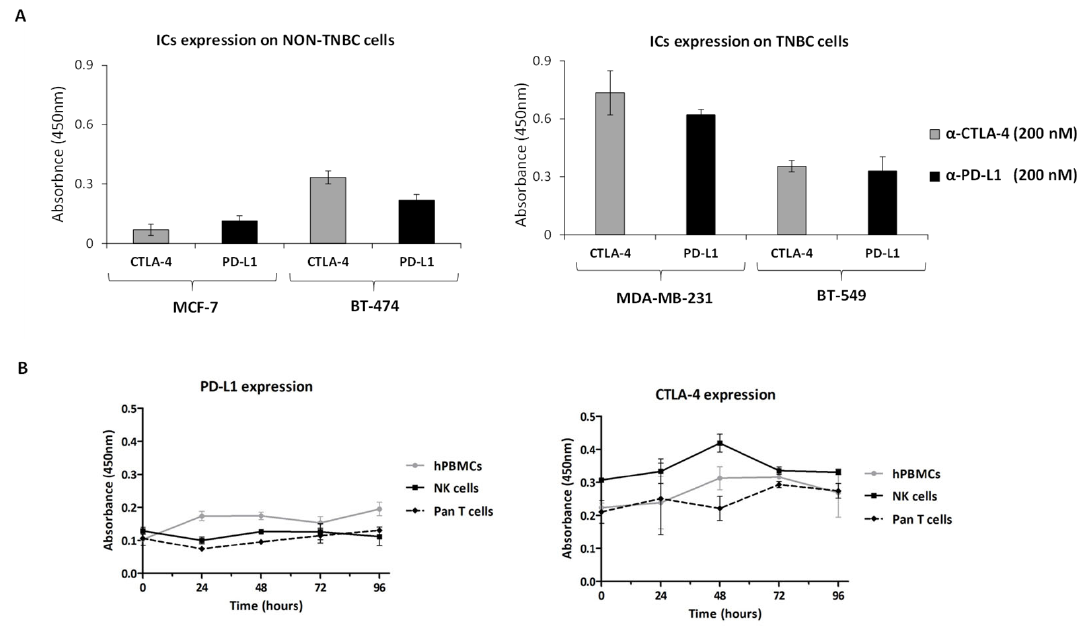
Figure 1. Expression of PD-L1 and CTLA-4 on breast cancer and immune cells. ( A ) Cell ELISA assays were performed by incubating BT-474, MCF-7 (( A ), panel on the left), MDA-MB-231 or BT-549 (( A ), panel on the right) cells with the commercial anti-PD-L1 or anti-CTLA-4 mAb at the indicated concentrations. ( B ) hPBMCs (grey curves), NK cells-enriched (black curves) or Pan T cells-enriched populations (dashed black curves) were incubated with SEB (50 ng/mL) for different time intervals (24, 48, 72 and 96 h) and then tested with the anti-PD-L1 or anti-CTLA-4 commercial mAb (200 nM) to measure the cell surface expression of the indicated ICs. The values were reported as the mean of at least three determinations obtained in three independent experiments. Error bars depicted means ± SD.